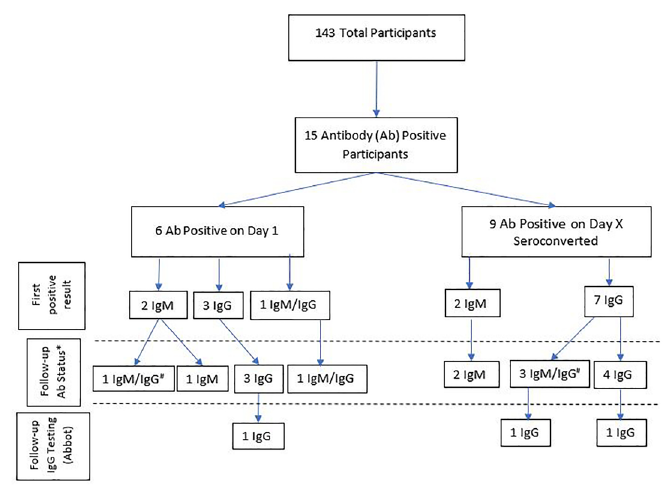
Figure 3. Flow diagram of results for antibody positive participants in study of seroprevalence of COVID-19 in a pediatric emergency department. IgM, immunoglobulin M; IgG, immunoglobulin